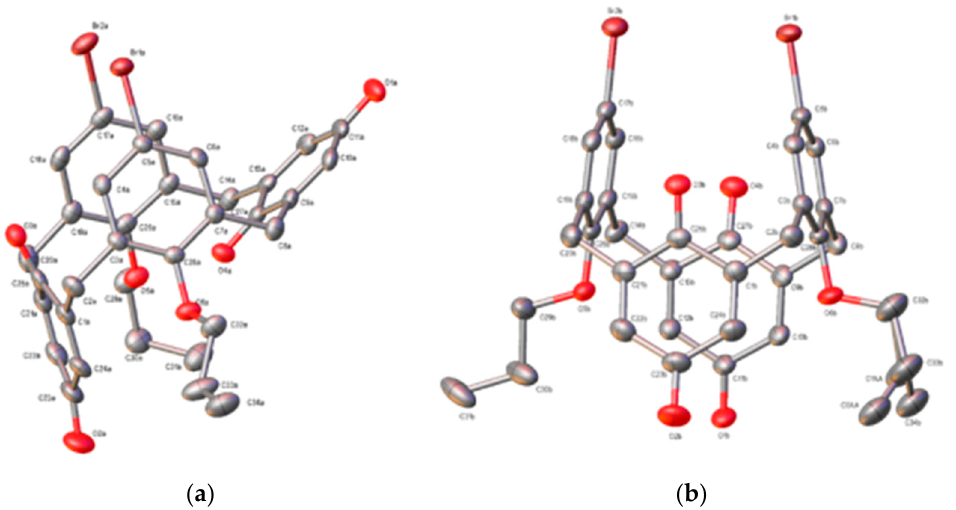
Figure 4. Alternative projections (relative to Figure 3) showing ellipsoid plots of the molecular structure of 1a ( a ) and 1b ( b ). Hydrogen atom and other conformers from the asymmetric unit in 1 have been removed for clarity in each case. Thermal ellipsoids shown at 50% probability.